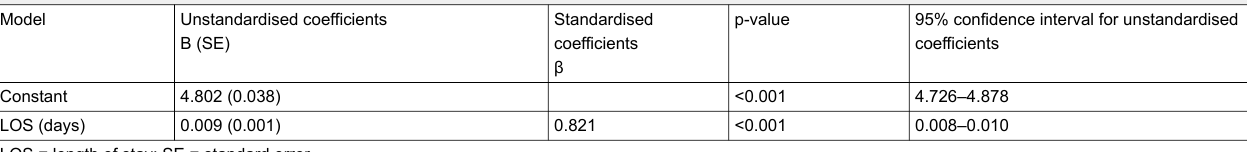
Table 3: Summary of regression coefficients – linear regression model predicting the decadic logarithm of total costs per case. Study population: severe burns discharges from all Swiss university care centres (n = 109).